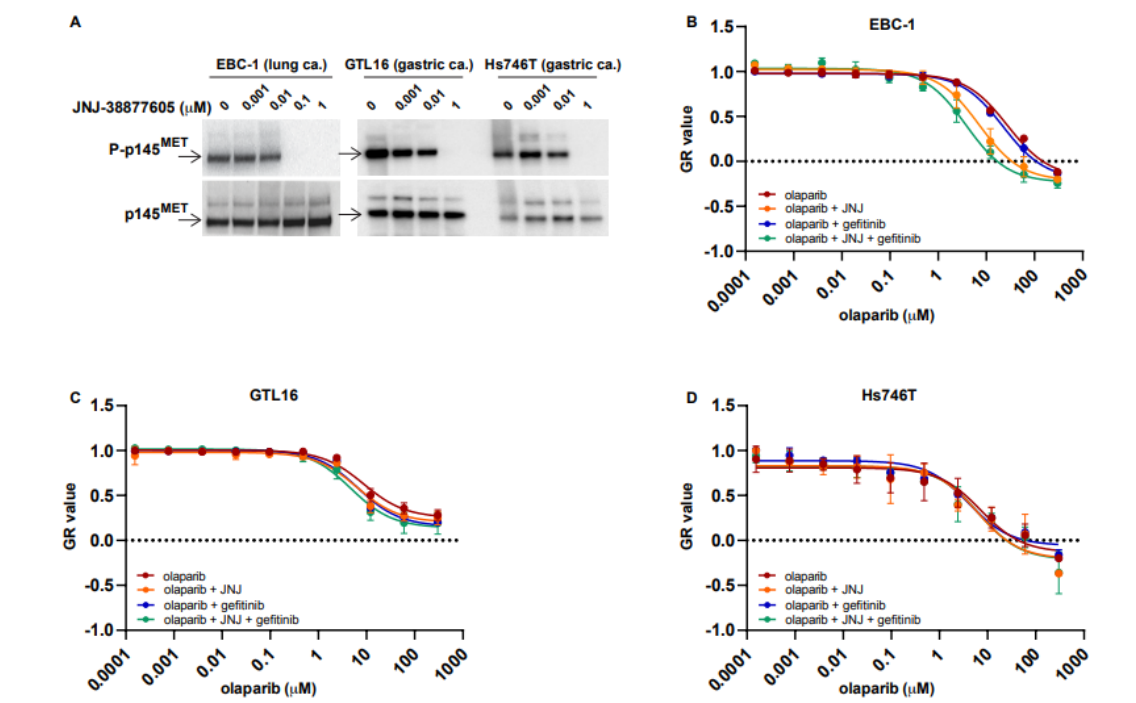
Figure 2. Growth rate of MET overexpressing cells (EBC-1, GTL16 and Hs746T) treated with the PARPi olaparib and either MET inhibitor JNJ-38877605 or EGFR inhibitor gefitinib. ( A ) Expression and phosphorylation status of the p145 MET receptor subunit in response to the indicated concentration of the inhibitor JNJ-38877605 (JNJ). ( B – D ) Growth rate (GR) of MET overexpressing cells treated with PARPi olaparib and either MET inhibitor JNJ-38877605 (10 nM) or EGFR inhibitor gefitinib (0.5 μ M), evaluated using a 5-day crystal violet assay. Normalized growth rate (GR value) inhibition metrics have been used that take into account cell division rates across the cell lines. The sign of GR values relates directly to response phenotype: positive for partial growth inhibition, zero for complete cytostatic effect and negative for cytotoxicity. In B-D, the EBC-1 ( B ), GTL-16 ( C ) and Hs746T ( D ) cell growth rates after treatment with the indicated concentration of olaparib in combination with either JNJ or gefitinib.